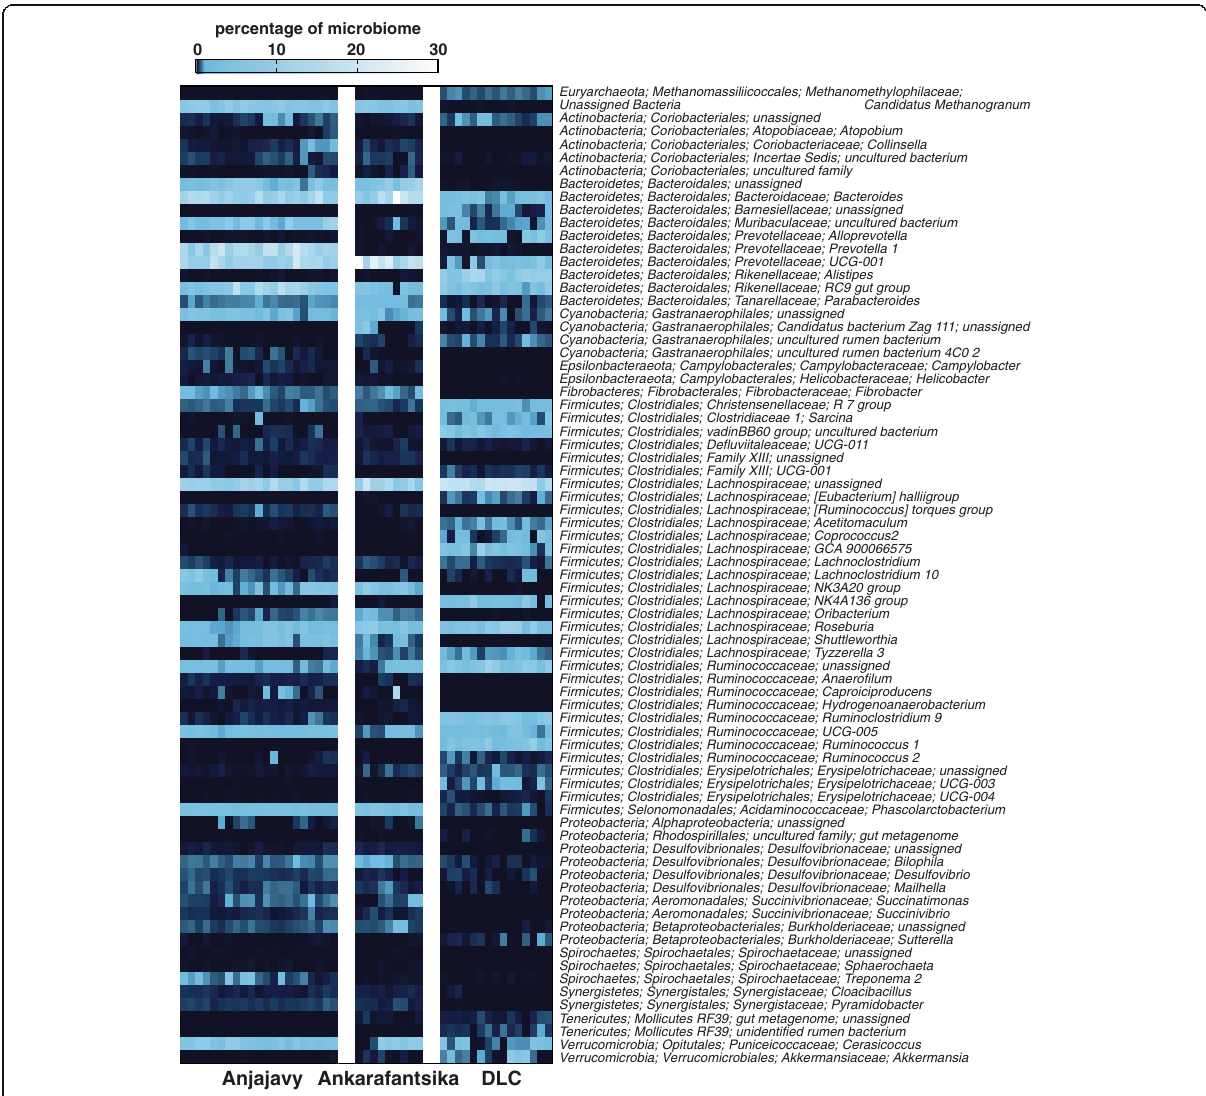
Fig. 3 Heat map of the microbial genera that were significantly enriched in one of the three study populations, including wild sifakas living in the Anjajavy Protected Area or Ankarafantsika National Park and captive sifakas housed at the Duke Lemur Center (DLC). Rows depict the percentages of each microbe relative to the total microbiome, with abundances increasing from dark to light colors. The microbes ’ phylogenetic phyla, orders, families, and genera (as available) are provided on the right. Each column represents one sample from one